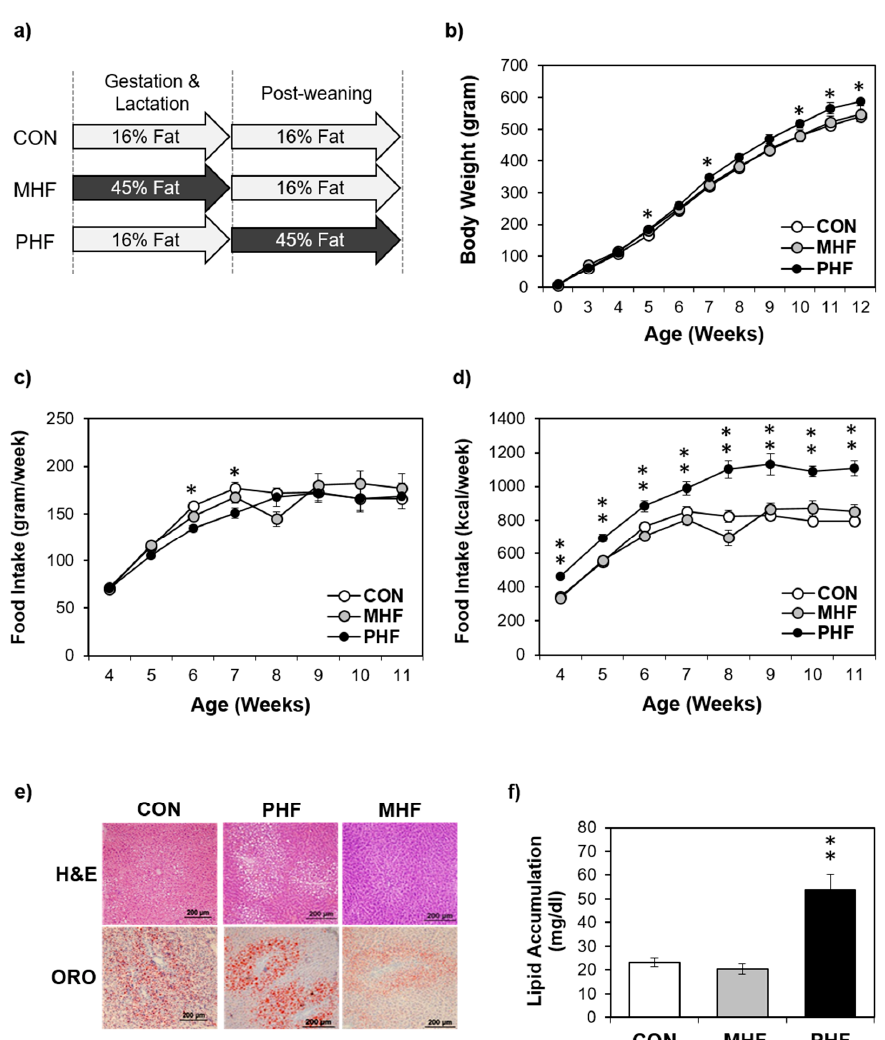
Figure 1. Physiological di ff erences between perinatal and post-weaning HF diet exposure. ( a ) The experimental design involved pregnant dams that were fed either a HF diet (45% kcal from fat) or a standard AIN93G control diet throughout gestation and lactation. At weaning, male pups from control diet-fed dams were weaned onto either the same control diet or HF diet, and male pups from HF-fed dams were weaned onto the control diet, creating three groups of pups, control (CON; n = 8), post-weaning high fat (PHF; n = 9) and maternal high fat (MHF; n = 7), respectively. ( b ) Body weight was measured weekly during the post-weaning period. ( c ) Weekly food intake was monitored during the post-natal period. ( d ) Caloric intake as kcal/week was calculated based on the grams of food intake. ( e ) Liver cross-sections were stained with hematoxylin and eosin (H&E) (top) and Oil Red O (ORO; bottom). ( f ) PHF animals had greater hepatic lipid accumulation than MHF and CON rats. Lipid accumulation was normalized to total protein. Data points represent mean ± standard error of the mean (SEM). *denotes a significant difference ( p < 0.05) between PHF and CON. **denotes a significant difference ( p < 0.01) between PHF and CON as well as between PHF and MHF.